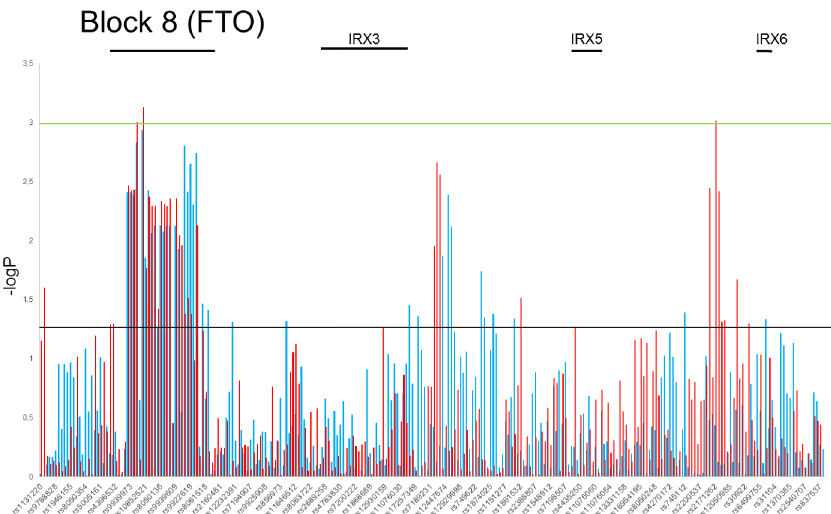
Fig 3. Distribution of estimated p values of the Chi square test in obesity phenotype stratified by age and sex. P values were calculatedin the test of independence betweenthe obesity phenotype and MAFs at tested SNPs (S4 Table). The y axis shows the − log 10 p values of 262 SNPs obtainedin obesity versus normal weight associationanalysis,and the x axis shows their rs numbers. Horizontalblack and green lines represent the thresholds of p = 0.05 for significancewithout multiplecorrection and p = 8.2E-04 for LD block significance, respectively.Red and blue columns represents females and males group, respectively.